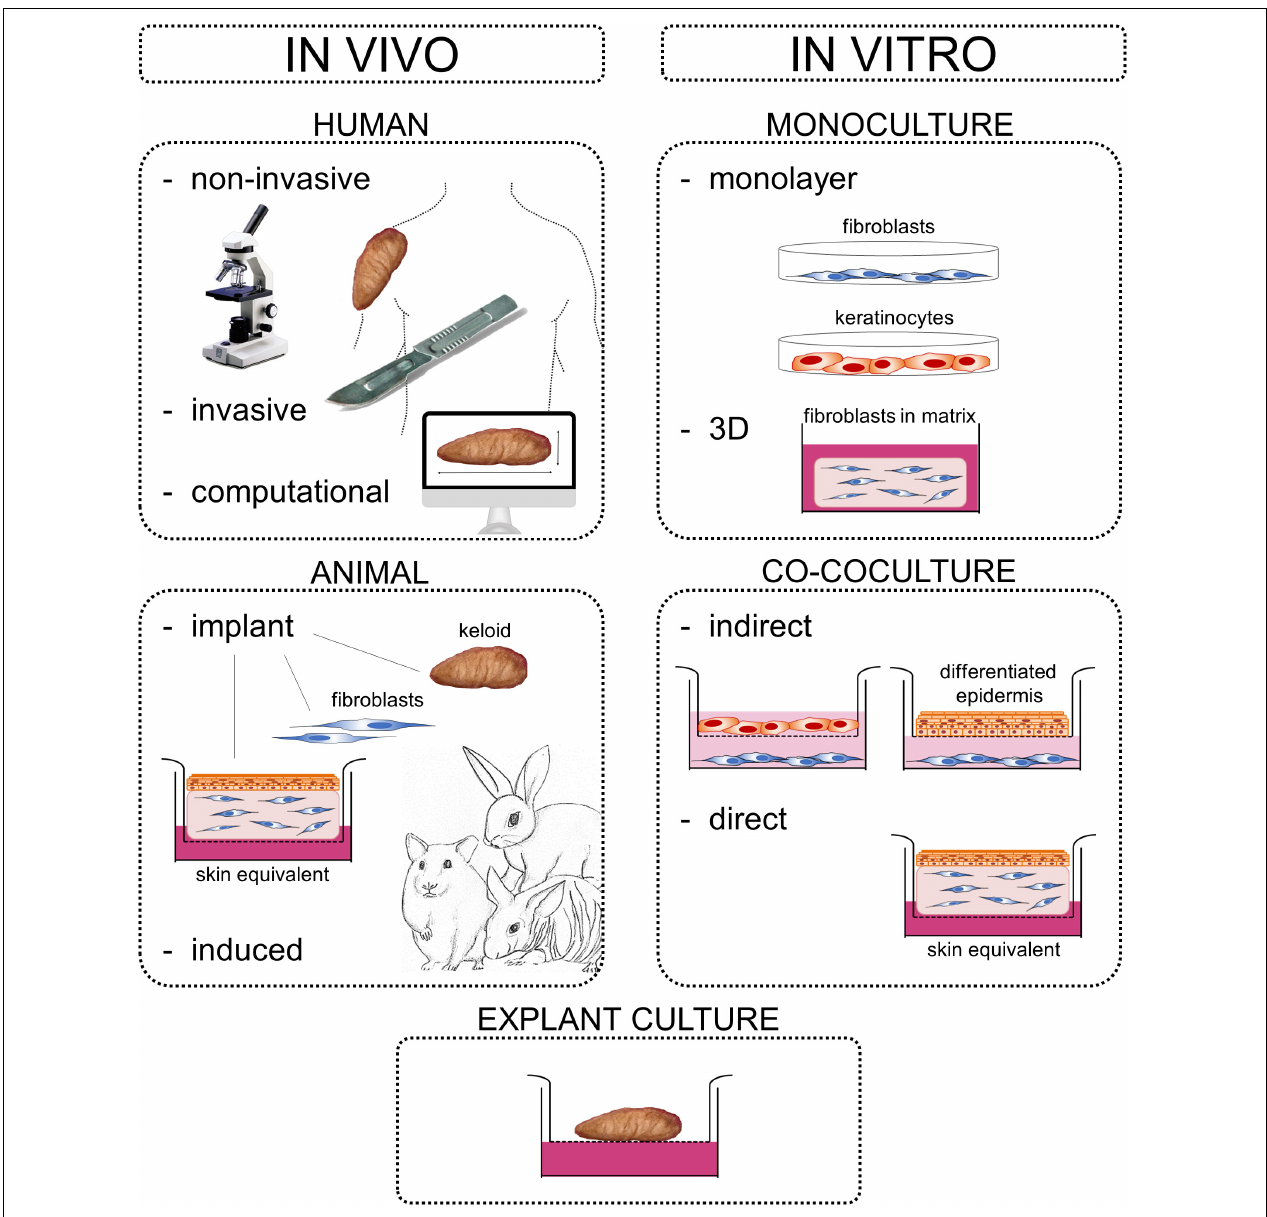
FIGURE 3 | Keloid scar models. Overview of available keloid scar models. Keloid models can be further subdivided into in vivo and in vitro models, which can be of human or animal origin. Human in vivo models include non-invasive testing methods (e.g., imaging and microscopy) and invasive methods, such as serial biopsy or inducing keloid formation by wounding. Animal in vivo models include implantation of keloid tissue fragments, fibroblasts or full thickness skin equivalents, as well as inducing keloid scar development by irritation or wounding. In vitro keloid models range from simple monolayers to 3D structures and co-culture systems. Indirect co-culture systems include monolayer keloid fibroblasts combined with either monolayer keratinocytes or a fully differentiated epidermis. Lastly, explant cultures are a combination of in vivo and in vitro as the method involves the maintaining of keloid tissue fragments in in vitro culture. Figure first published in Limandjaja (2019), used with